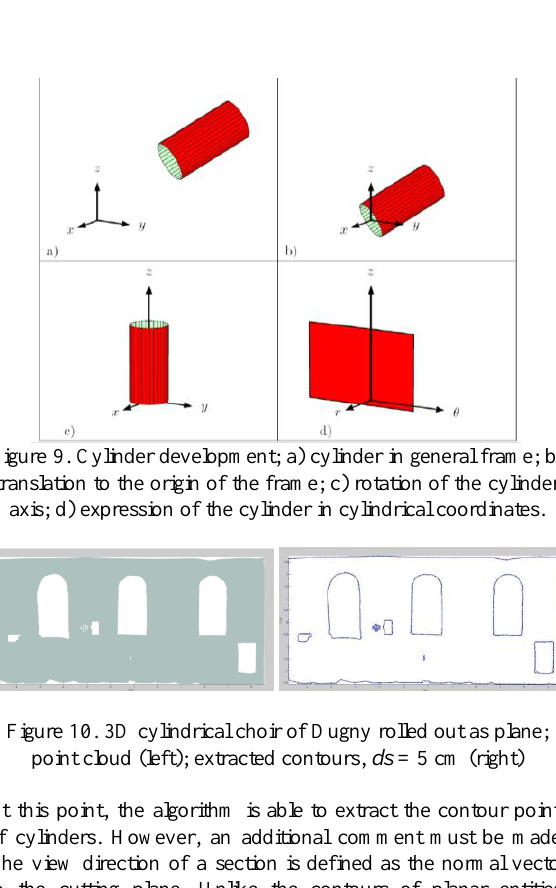
apparent contours, are dependent on the view direction (Rüegg and Burmeister, 2010). Figure 11 illustrates the fact that a cylinder must be represented differently given the chosen view direction.